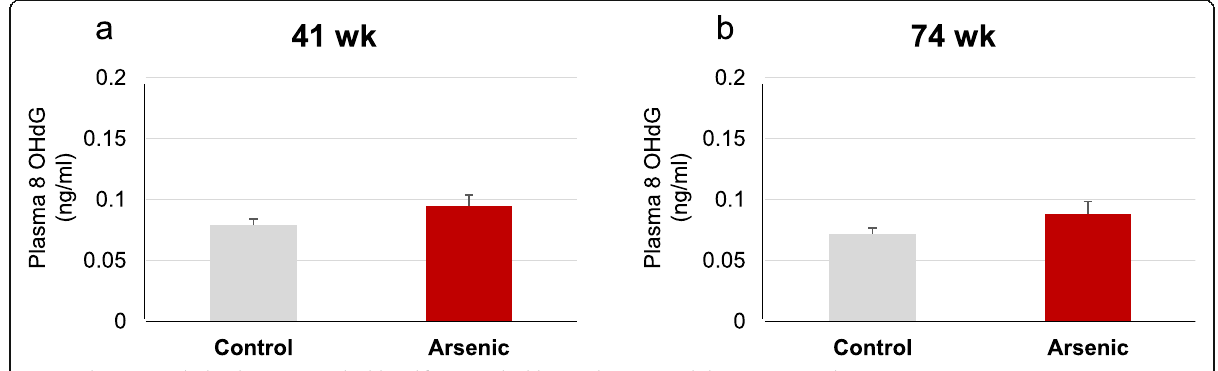
Fig. 7 Plasma 8OHdG level in a 41-week-old and b 74-week-old F2 male mice. Each bar represents the mean ± SE ( n =